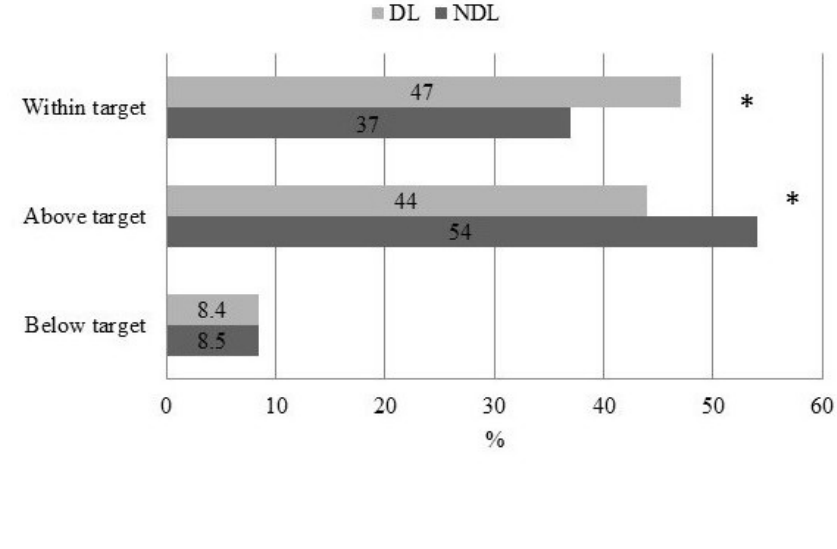
Figure 4. Percentage of values within, above, and below target of No-downloader (NDL) and Downloader (DL) at follow-up visit.